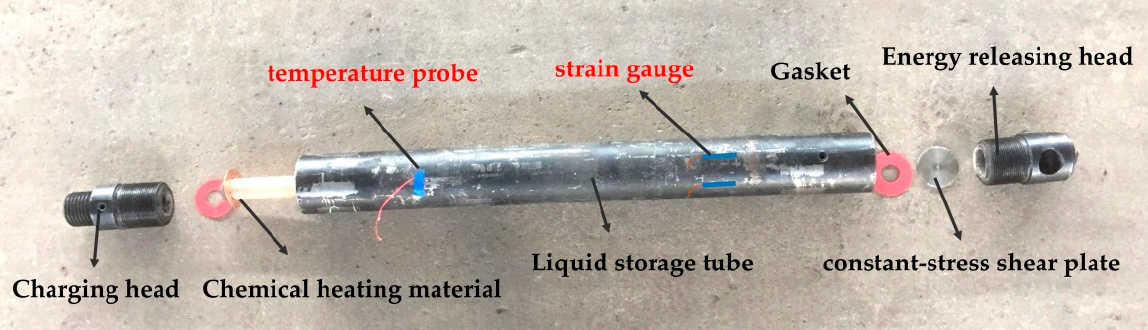
Figure 1. The structure of carbon dioxide fracturing pipe.